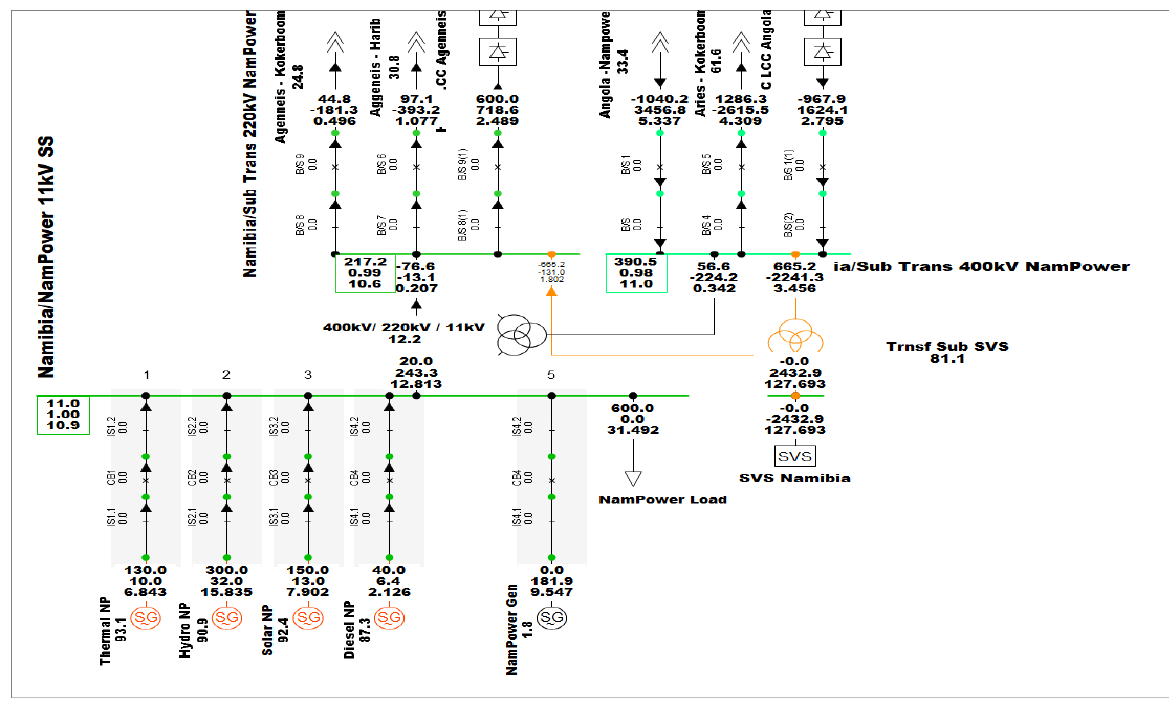
Energies 2023 , 16 , x FOR PEER REVIEW Figure 12. Namibia power network with the static var system. Figure 12. Namibia power network with the static var system.